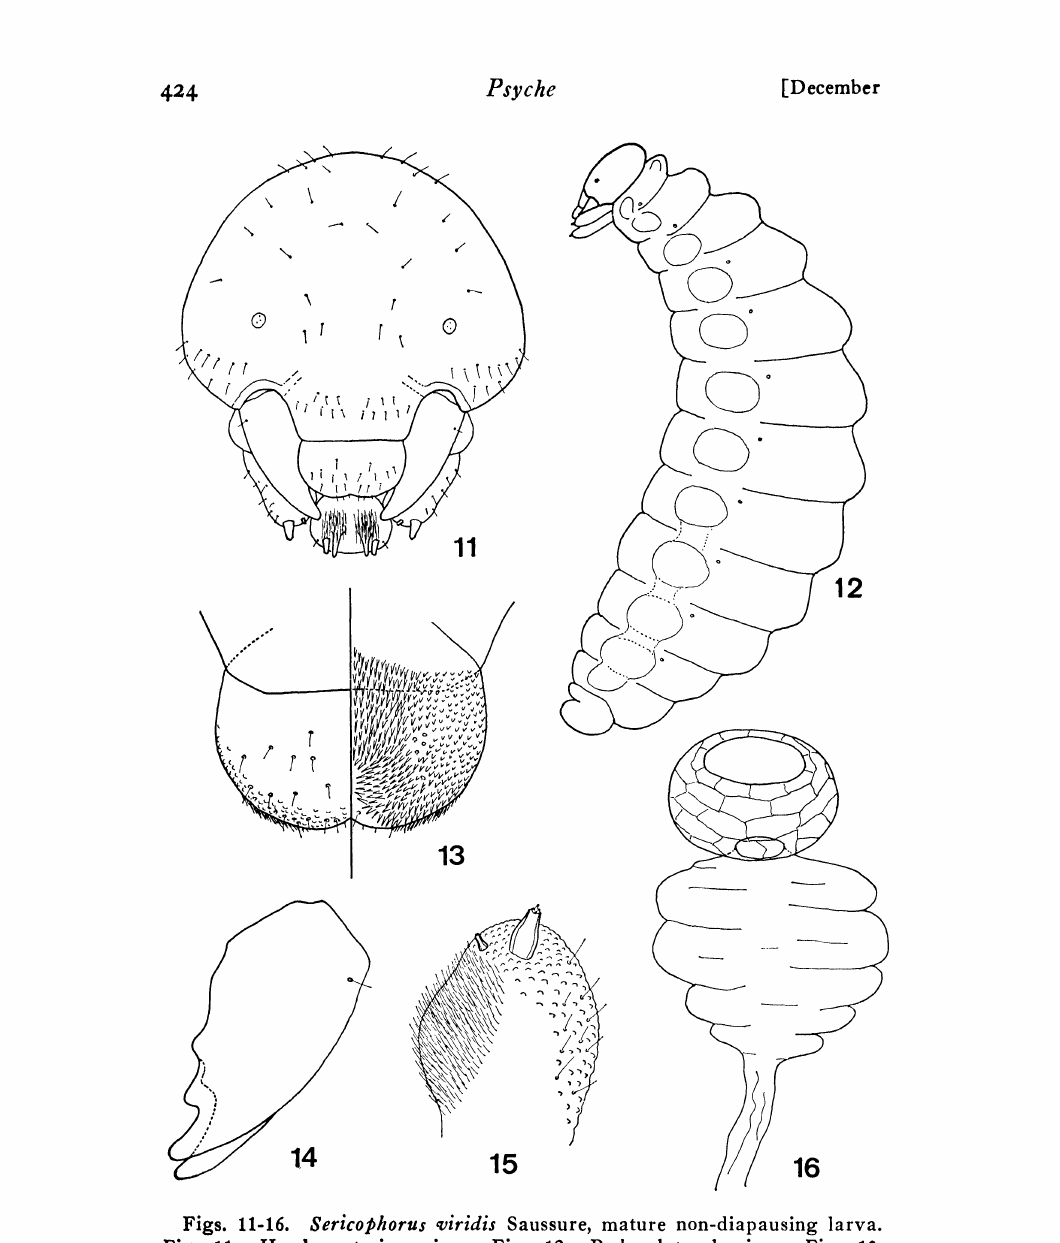
Figs. 11-16. 8ericophorus eiridis Saussure, mature non-diapausing larva. Fig. 11. Head, anterior view. Fig. 12. Body, lateral view. Fig. 13. Labrum (left) and epipharynx (right). Fig. 14. Mandible, dorsal aspect. Fig. 15. Maxilla, mesal margin at left. Fig. 16.